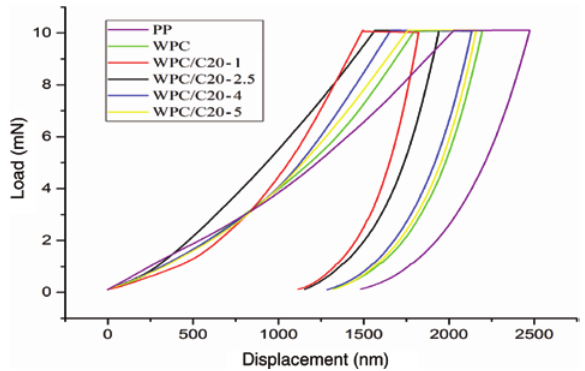
Figure 2: Typical indentation load-displacement curves for PP, WPC and WPC with different C20 organoclay